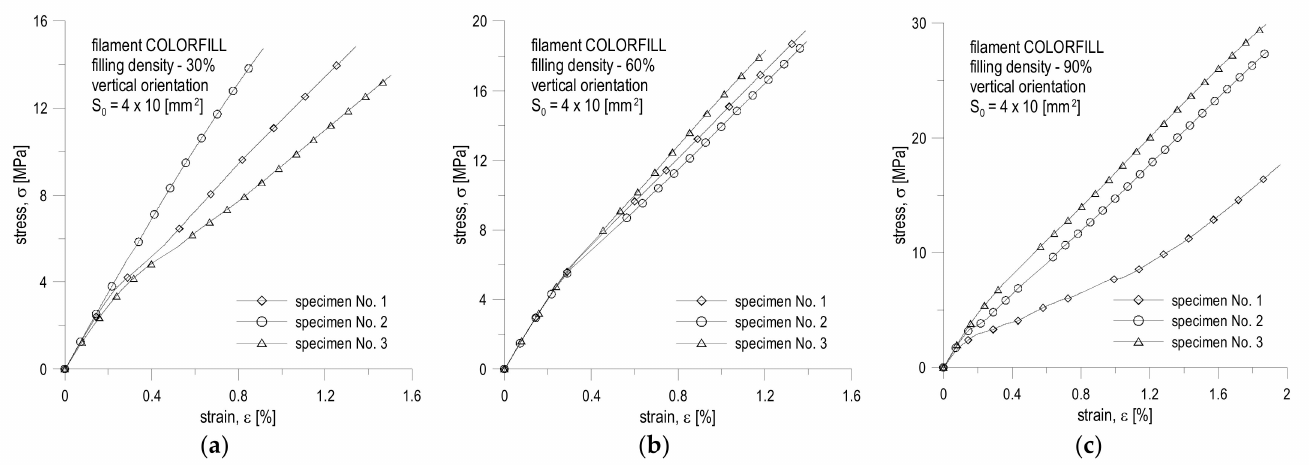
Figure 11. Tension curves for specimens with a different filling for vertical orientation made of COLORFILL filament: ( a ) 30% filling; ( b ) 60% filling; ( c ) 90%